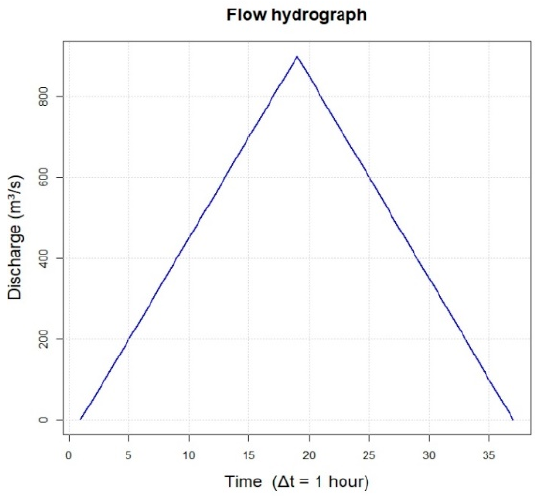
Figure 3. Flow hydrograph used as an upstream boundary condition for the synthetic tests.